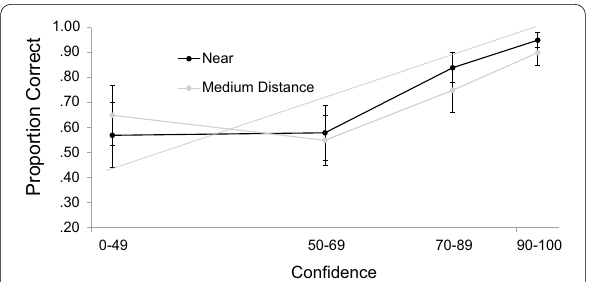
Fig. 3 Calibration Curves for Faces that were Presented at a Near or Simulated Far Distance in Experiment 1b. Note: The diagonal line indicates optimal calibration. Bars represent descriptive 95% confidence